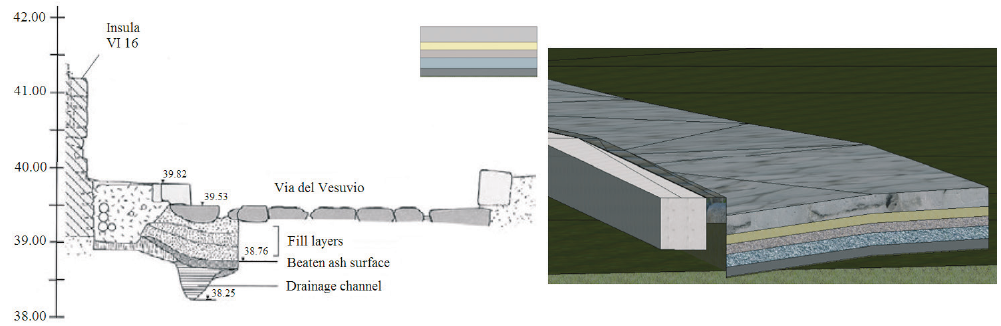
Figure 5. Section of Via del Vesuvio (Seiler, Beste, Piraino & Esposito, 2005) and its relative 3D visualization